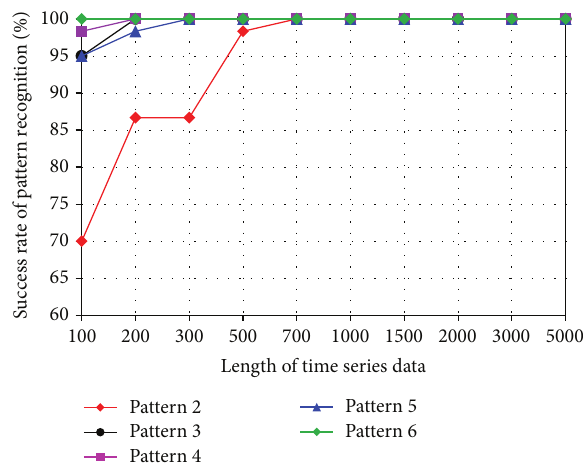
Figure 8: Success rate of pattern recognition for first scenario (pattern 2–6) using Mahalanobis distance.